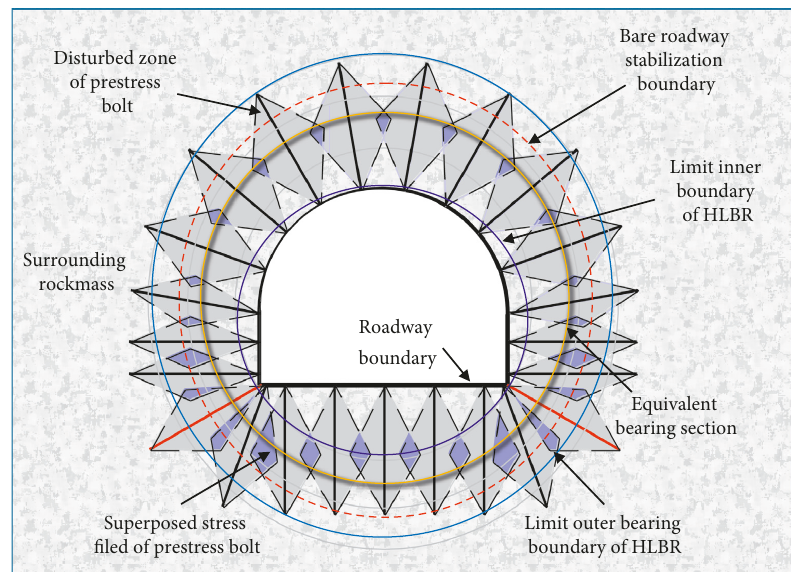
Figure 1: Model of HLBR.